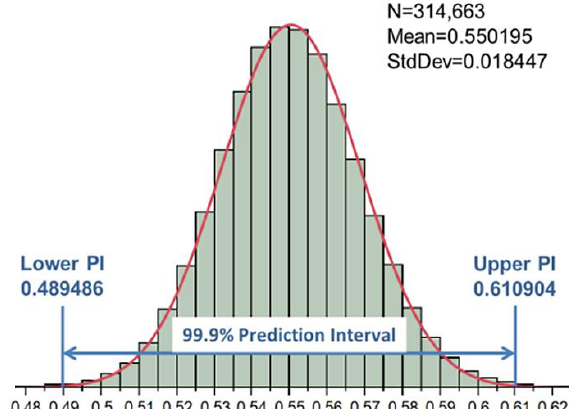
Figure 3. Variation in weak coherent pulse Mean Photon Number (MPN) emitted from Alice’s modeled laser due to expected fluctuations and performance limitations in the modeled decoy state generator (i.e., the variable optical attenuator). The upper and lower Prediction Intervals (PI) are shown to bound the expected performance.